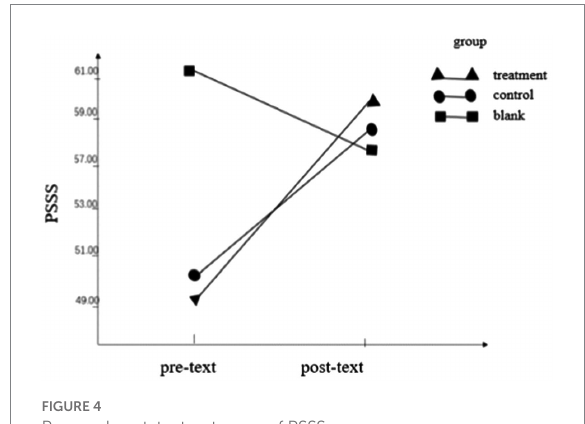
FIGURE 3 Pre- and post-text outcome of UCLA.